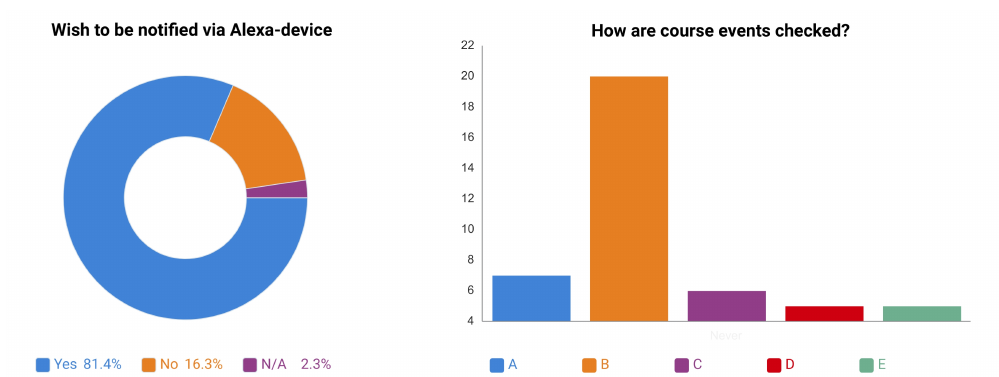
Figure 10. Statistical data deviated from the feedback survey (Source: own authors’